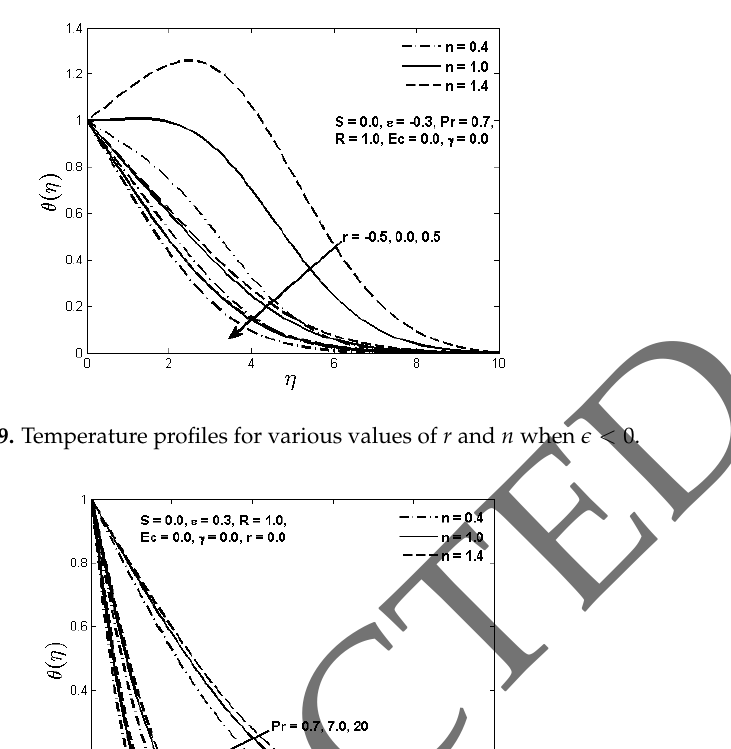
Figure 10. Temperature profiles for various values of Pr and n .